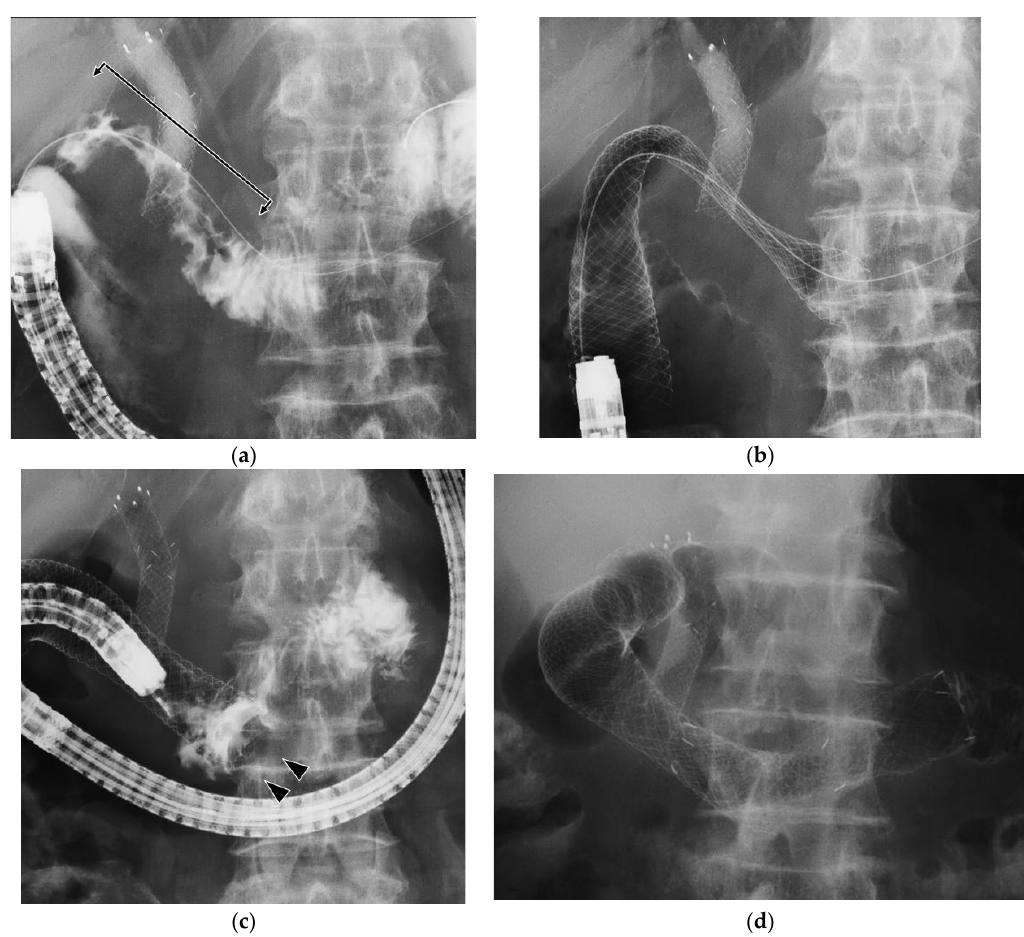
Figure 4. A case of abutment after duodenal stenting. ( a ): Duodenography via the endoscope showing D2 obstruction (arrow). ( b ): 12-CM stent was placed between D3 and gastric antrum. ( c ): Two days after stent placement, abutment of the anal side of the stent to the duodenal wall occurred (arrowhead), resulting in obstruction. ( d ): Additional duodenal stenting overlapping the former stent was performed for